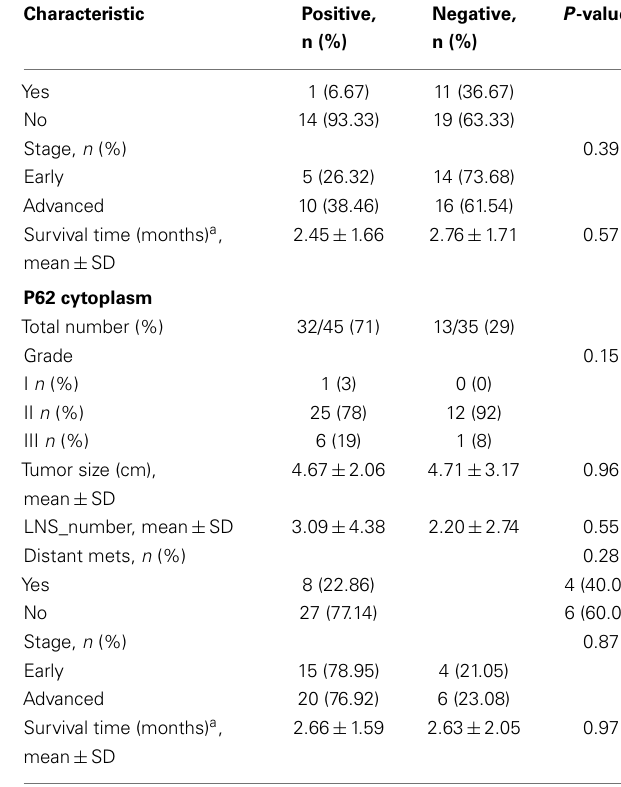
*P-values derived from chi-square or Fisher’s exact test for stage categories and two-sample t-test for log-transformed survival time. a Log-transformed. differentiated (21 vs 17, P = 0.04), but less lymph node